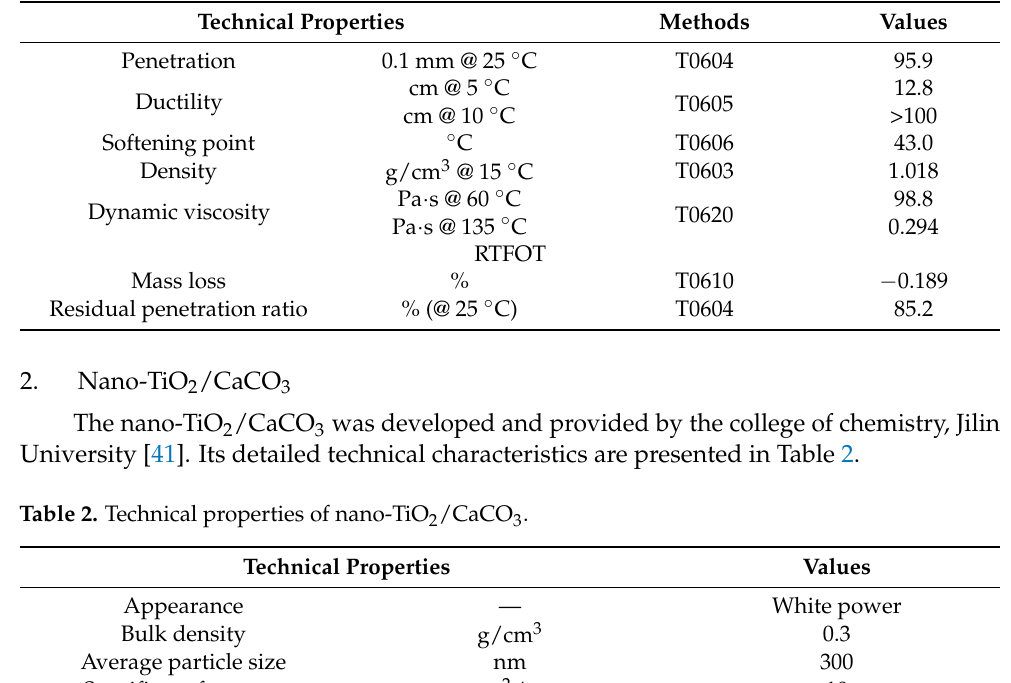
Table 1. Technical properties of 90# base bitumen.